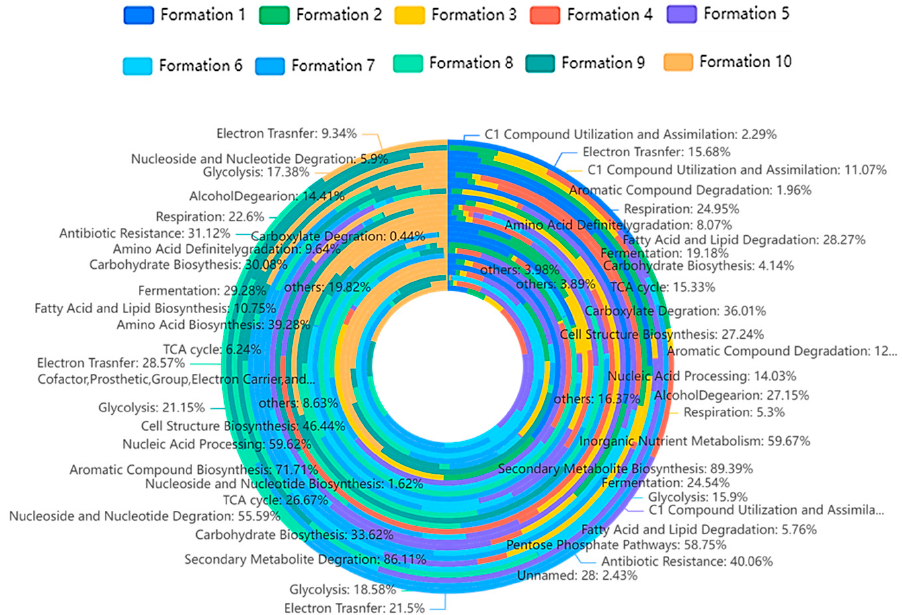
Figure 5. Data on the input side of the produced fluids traceability model. The data includes bacteria species and their percentage in each formation.